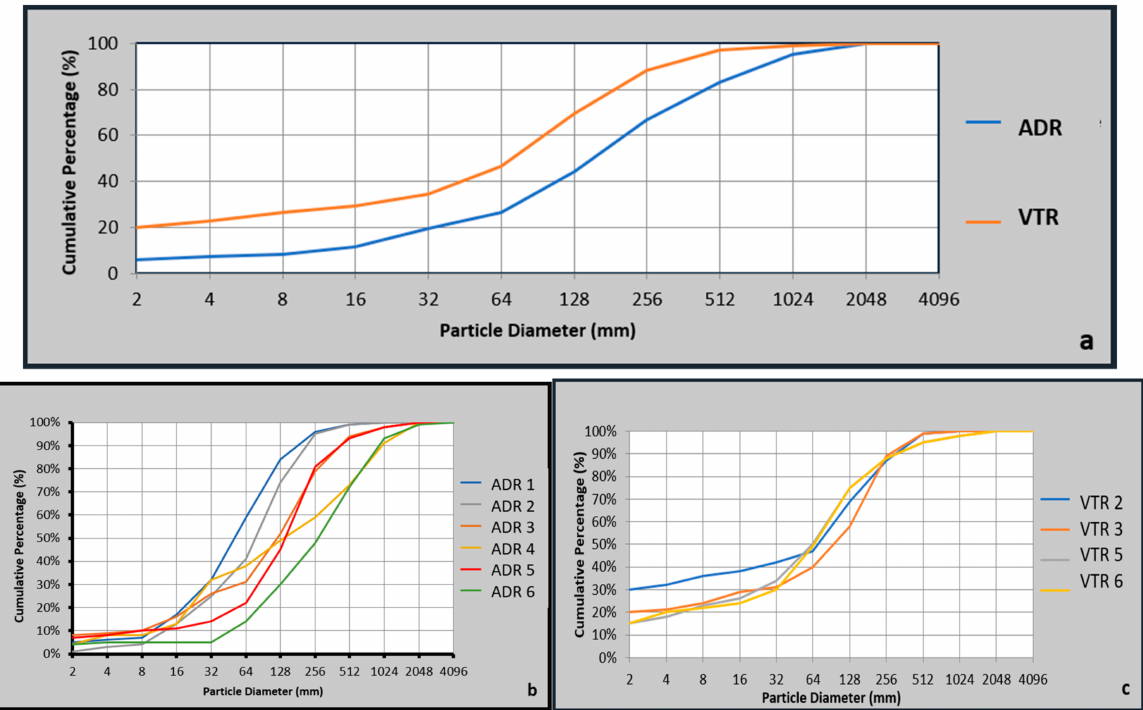
Figure 3. ( a ) Comparison of total particle size cumulative curves in Arkoudorema (ADR) and Vathirema (VTR). The cumulative percentage of the different size of the stream bed material for the 6 sampling stations in the ADR ( b ) and the 4 sampling stations for the VTR ( c